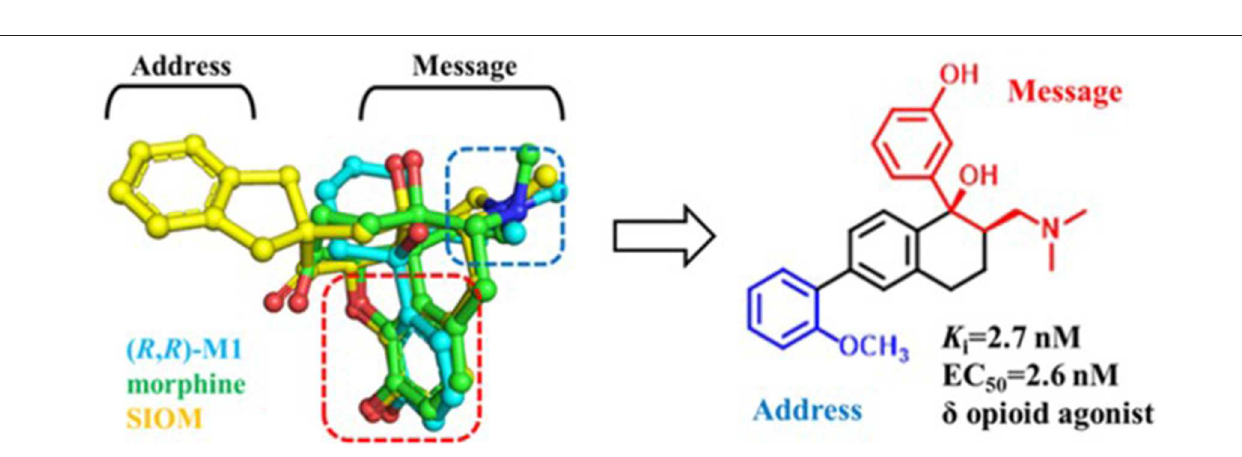
FIGURE 5 | Design of (–)-6j using “message–address” concept. The nitrogen atom and phenol fragment of both (1R, 2R)-M1 (O-metabolite of Tramadol, colored in cyan) and SIOM (a δ OR agonist, colored in yellow) overlapped very well after superimposing them together with morphine (colored in green). Different parts for these compounds are labeled according to the “message–address”